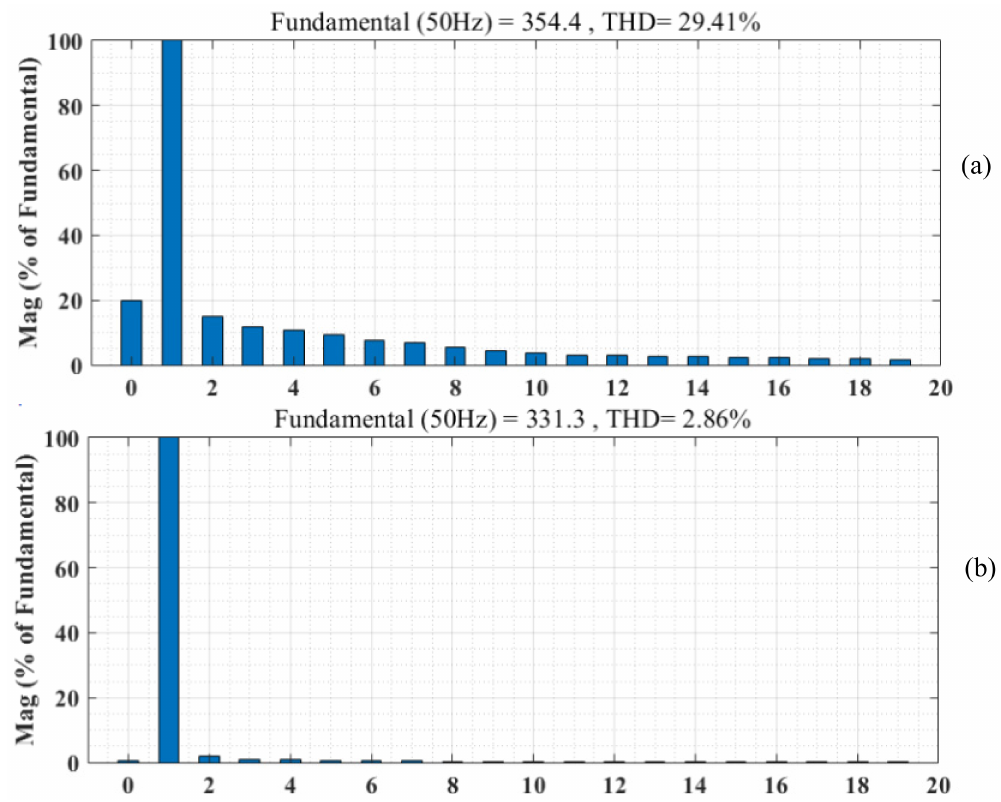
Figure 19. Fast Fourier transform analysis of AC input current: ( a ) controlled by the direct power control method; ( b ) controlled by the nonlinear feed-forward PID control